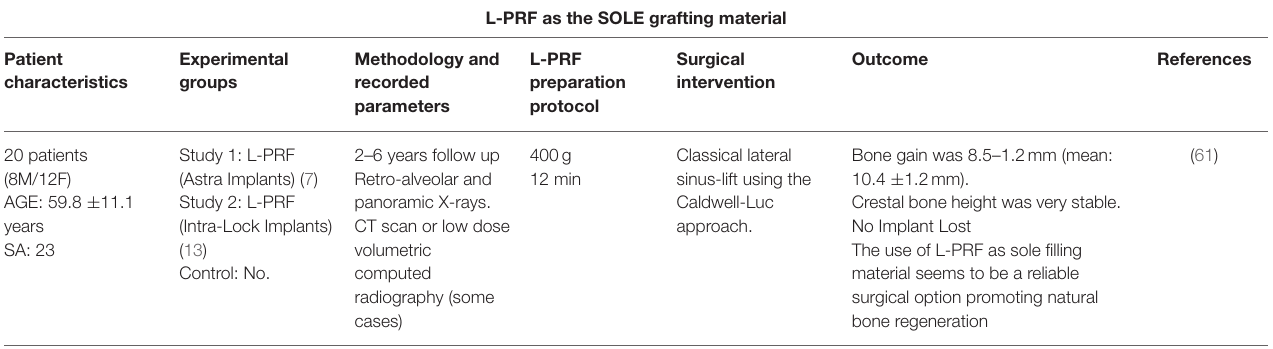
L-PRF as the SOLE grafting material